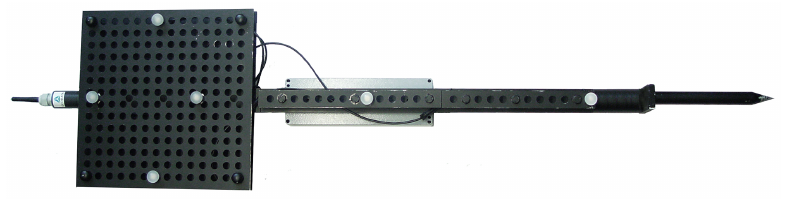
Figure 12. Developed target prototype.